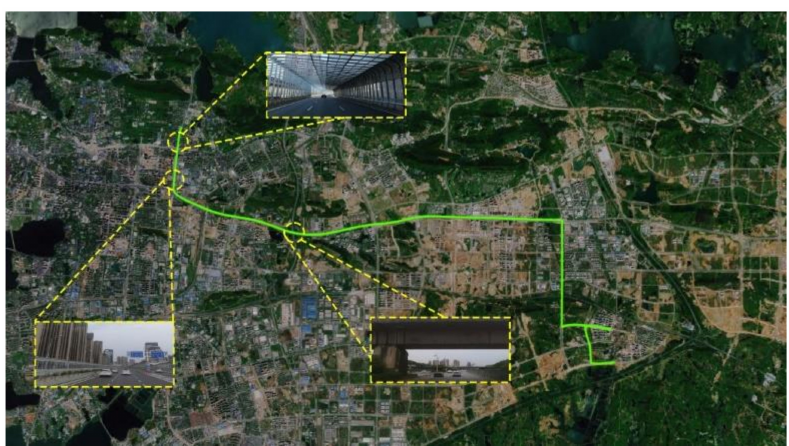
Figure 4. The trajectory of experiment C.